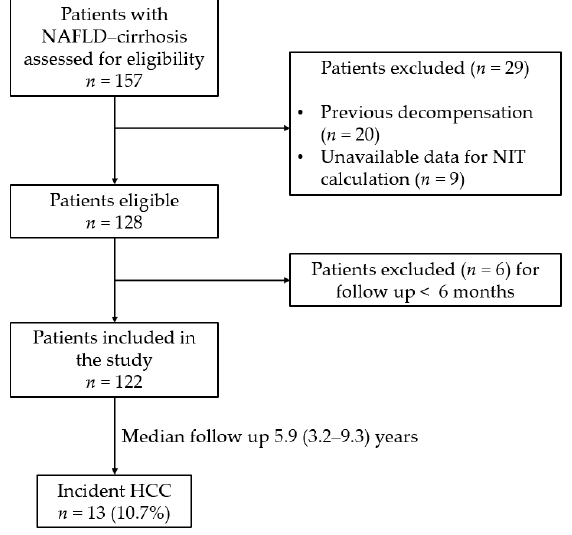
Figure 1. Flow chart of the study. Abbreviations: HCC: hepatocellular carcinoma. NAFLD: non- alcoholic fatty liver disease, NIT: non-invasive test.